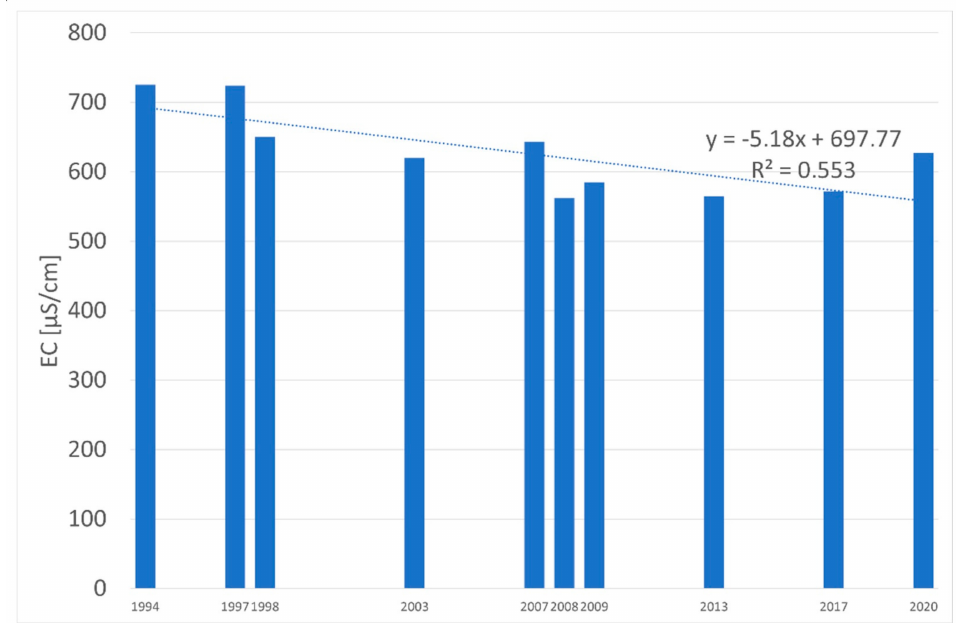
Figure 8. Changes in conductivity (EC) and the trend line in the Vistula in the period from 1994 to 2020.